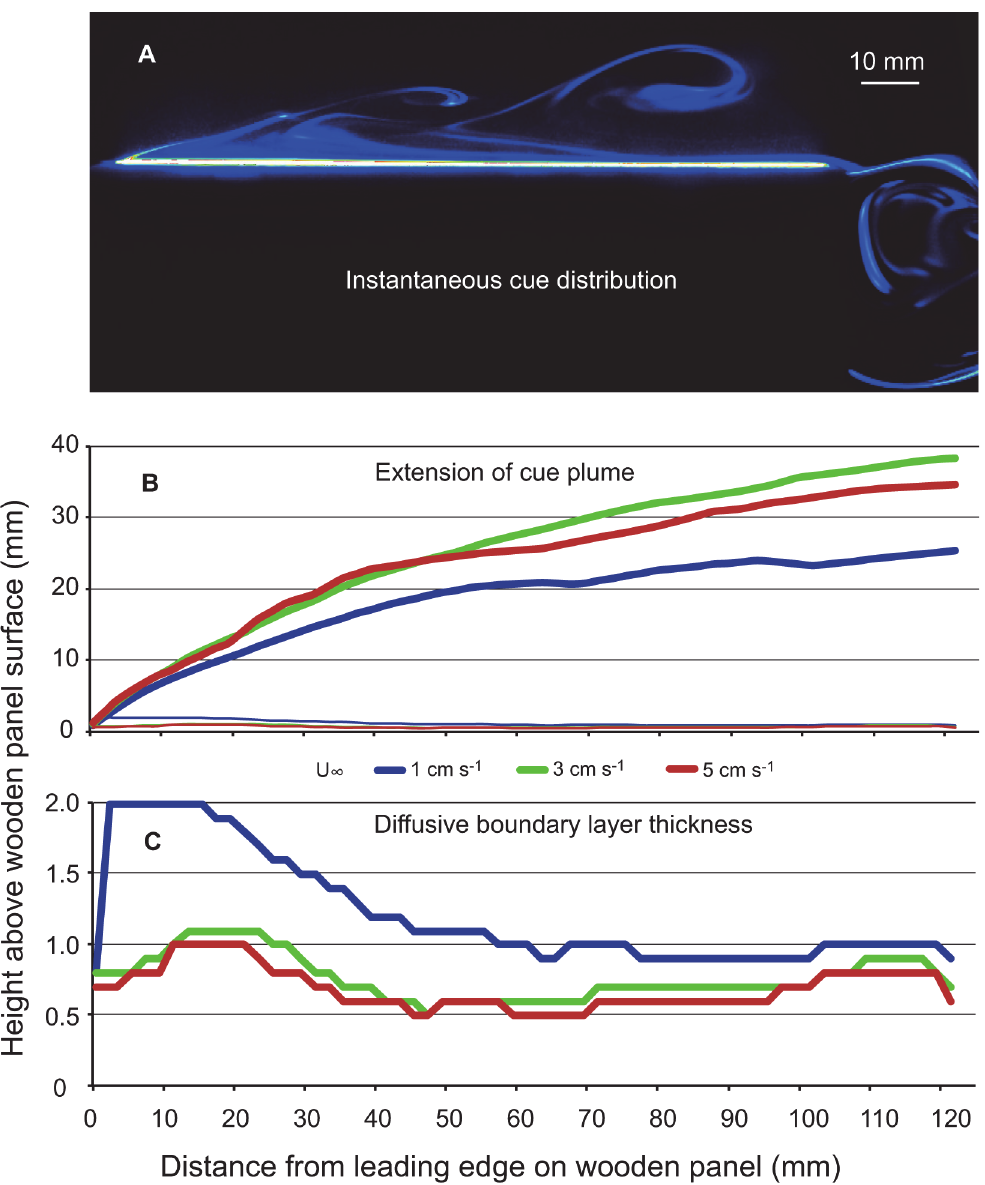
Fig 4. Laboratory flume experiment. Results from laser induced fluorescence (LIF) recordings on dye solution diffusing out of wooden panels. The fluorescent dye mimics any water soluble chemical that might act as attractive cues. A) Instantaneous cue distribution around the wooden panel at a free stream velocity of 1 cm s -1 with a high concentration diffusive boundary layer (DBL) on the panel surface and filaments of lower concentration transported from the DBL into the surrounding water. B) The maximum vertical distribution of cue filaments above the panel surface in the three tested free stream velocities; thin lines also show the DBL thickness for comparison. C) Average thickness of DBL as a function of free stream velocity and distance from the leading edge, i.e. upstream end of panel.